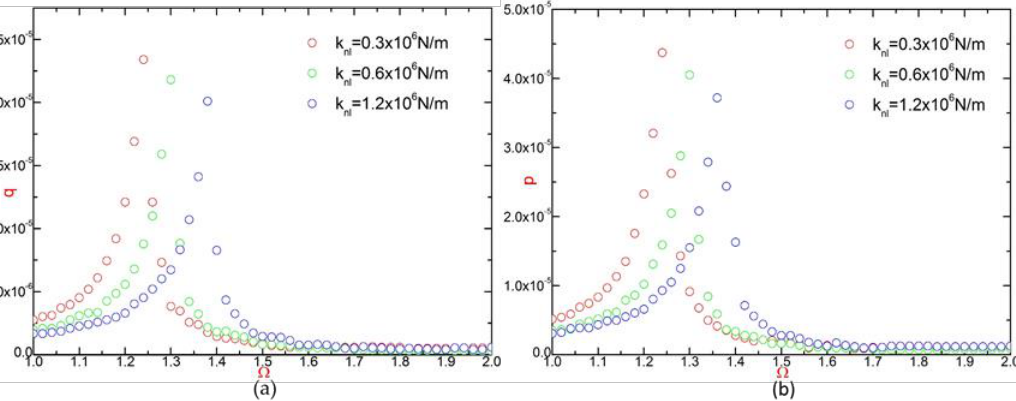
Figure 10. Influence of k ln in 1st order generalized coodinate of the frequency response curve ( a ) in transvese direction ( b ) in rotation direction.